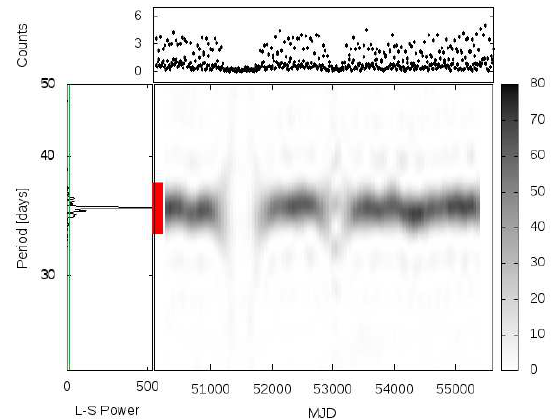
Figure 2: Her X-1: This steady super-orbital pe- riod have been associated with a stable radiation-driven